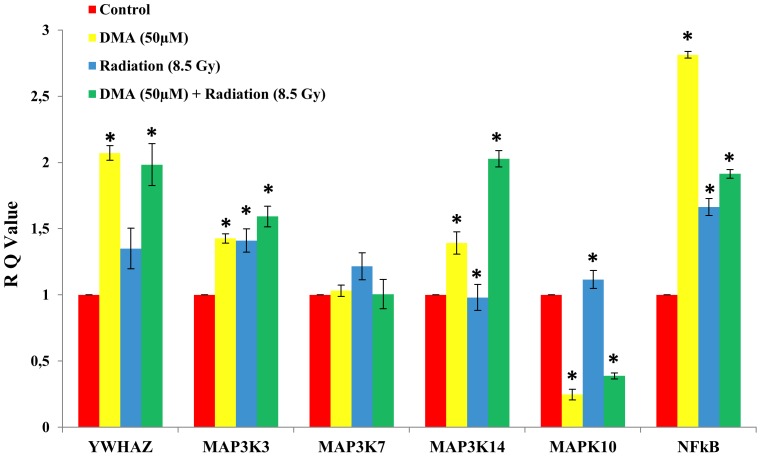
Relative quantitation of gene expression for MAPK pathway genes in U87 cells.U87 cells were treated with 50 µM DMA and/or 8.5 Gy ionizing radiation. RNA samples were prepared 4 h after treatments. YWHAZ (14-3-3 zeta), MAP3K3 (Mitogen activated protein kinase kinasekinase 3), MAP3K7 (Mitogen activated protein kinase kinasekinase 7), MAP3K14 (Mitogen activated protein kinase kinase 14), MAPK10 (Mitogen activated protein kinase 10) and NFκB (Nuclear Factor Kappa B/Rel A subunit) were quantitated by Real Time PCRusing RNA samples from U87 glioma cell line. Values represent Mean±S.D.(*indicates statistical significance by T-test, *p<0.05).